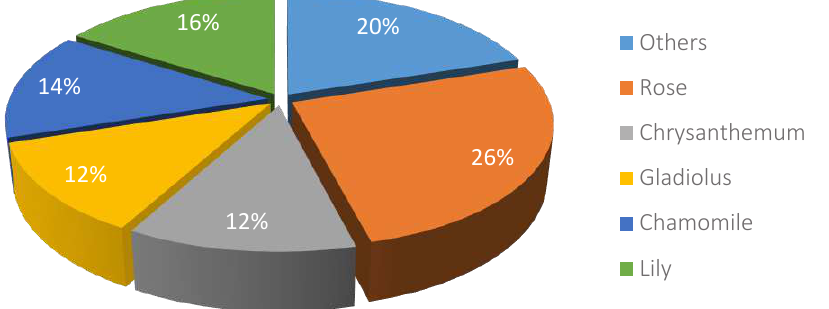
Figure 4. Structural analysis of flower